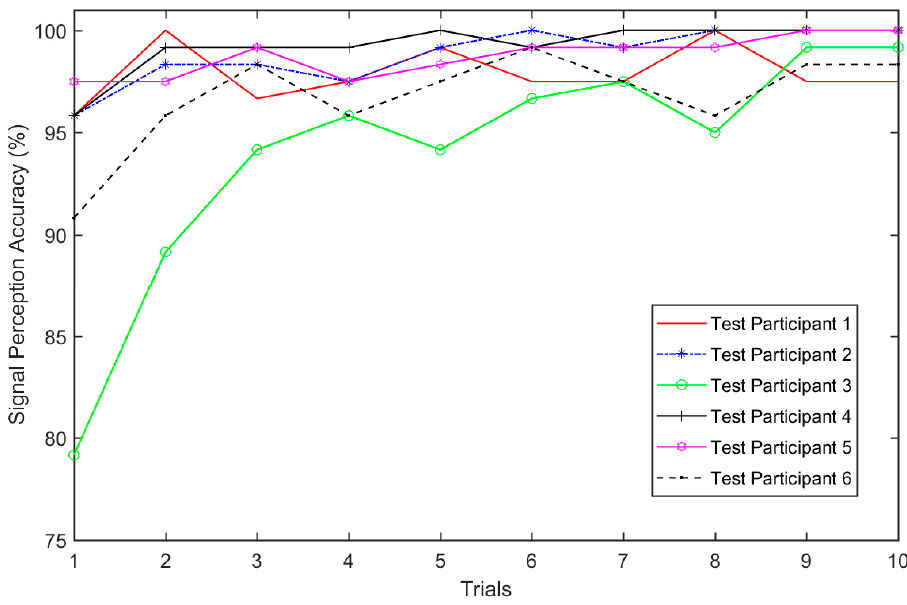
Figure 9. Individual signal perception accuracy.